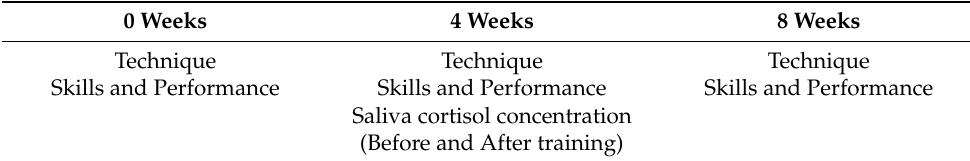
Table 3. Measurements’ schedule.